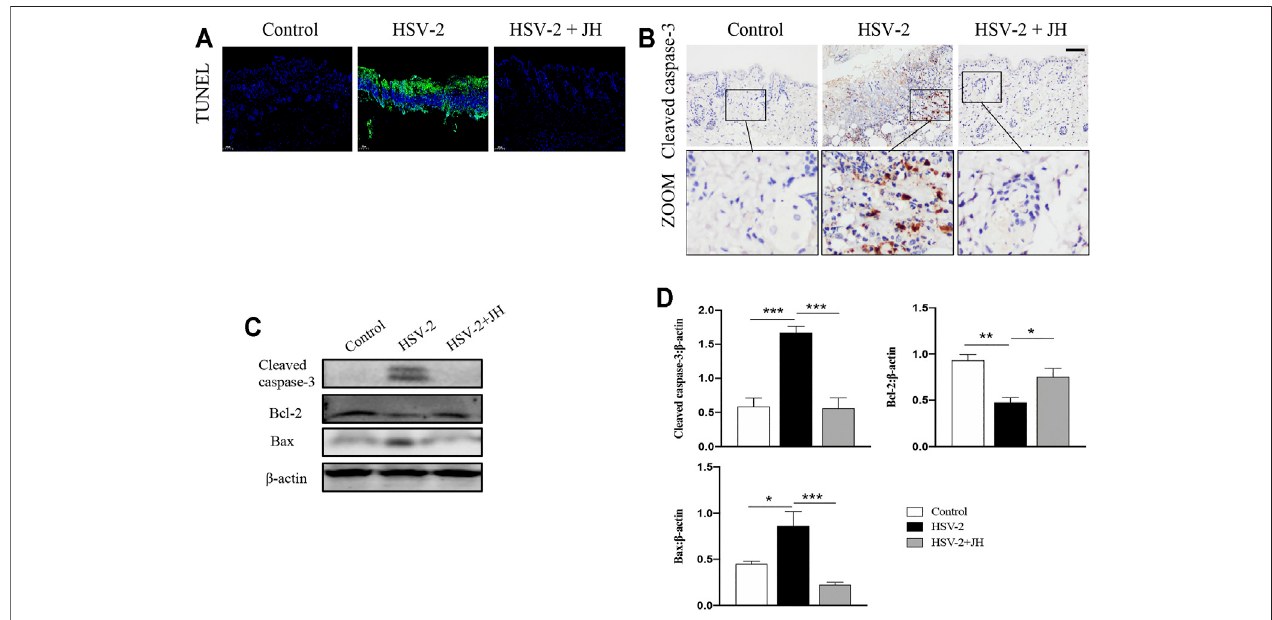
FIGURE 4 | JZ-1 administration suppresses cell apoptosis in HSV-2-induced GH. (A) Representative TUNEL staining in vulva. (B) Representative immunohistochemistry staining for cleaved caspase-3 in vulva. (C) Representative western blots for cleaved caspase-3 and Bax in vulva. (D) The quanti fi cation of cleaved caspase-3 and Bax western blots. All data are presented as means ± SEM. p < 0.01 (**), and p < 0.001 (***); ( n (cid:2) 6).